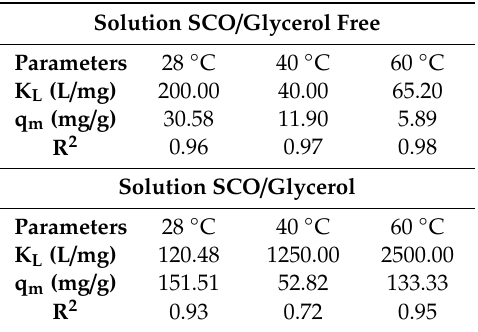
Table 2. Langmuir model parameters.